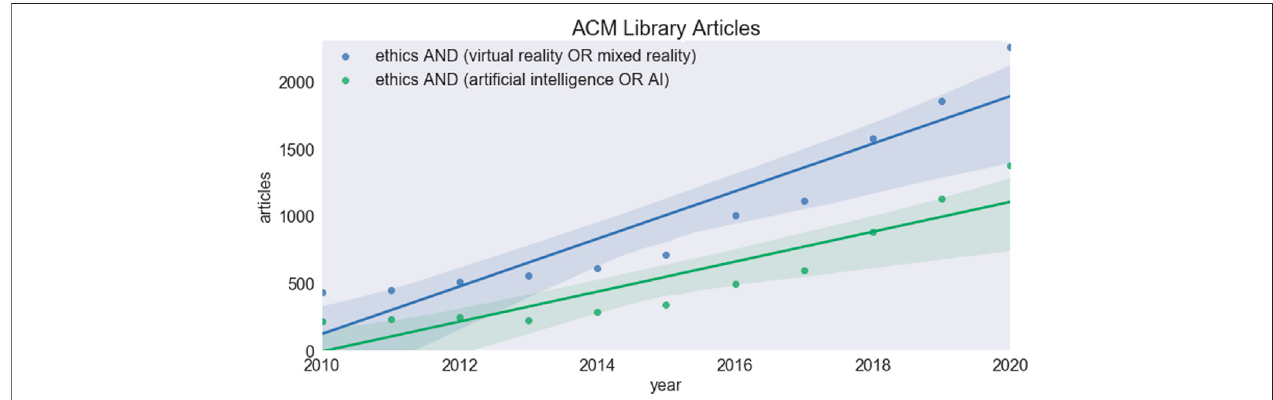
FIGURE 1 | Number of articles returned per year in the ACM Digital Library featuring the words mixed reality (ethics, mixed reality, virtual reality) vs. arti fi cial intelligence (ethics, arti fi cial intelligence,